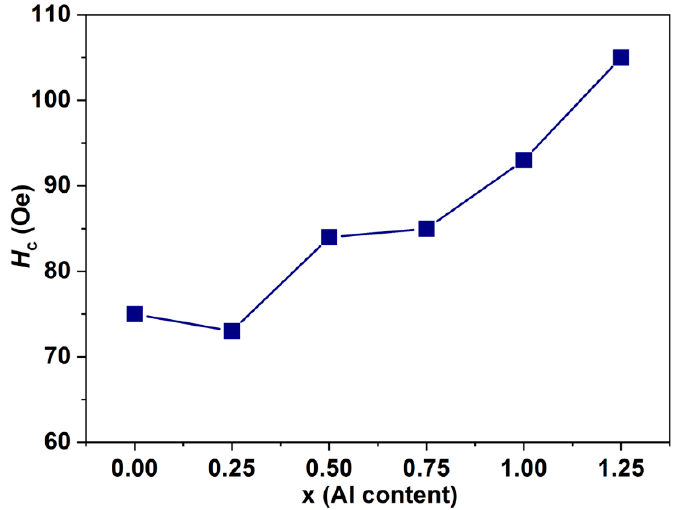
Figure 12. The impact of Al content (x) on the coercivity ( H c ) of the W-type SrYb hexaferrite Sr 0.85 Yb 0.15 Zn 1.5 Co 0.5 Al x Fe 16-x O 27 .